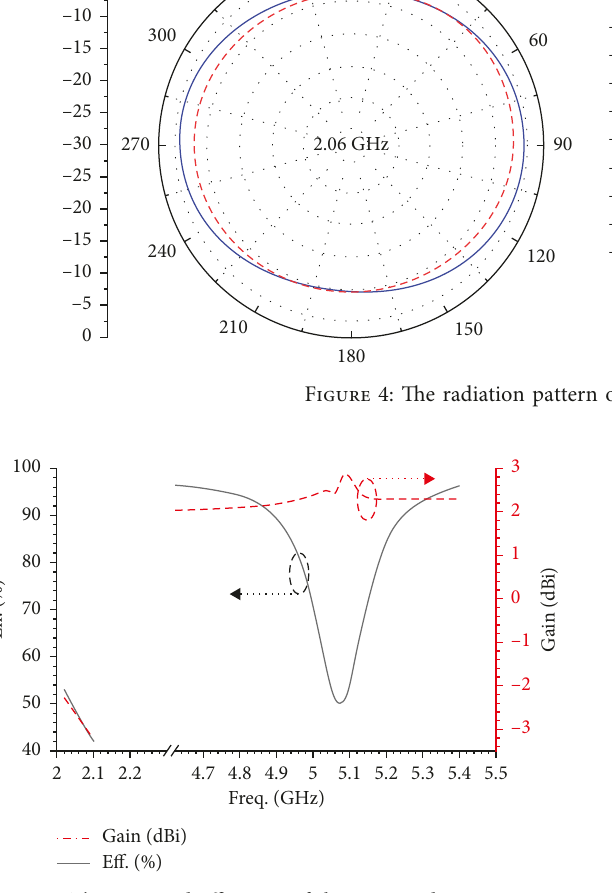
Figure 5: The gain and efficiency of the proposed MSB